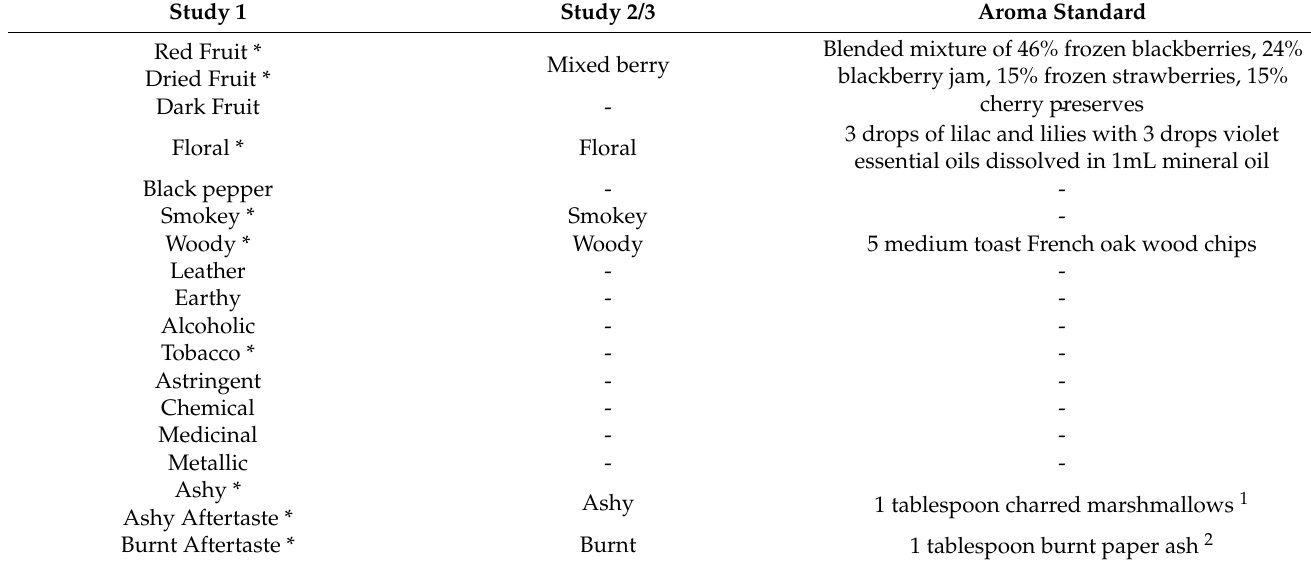
Table 2. Attributes evaluated during the CATA (Study 1) and TCATA (Study 2), along with standards used for training prior to FTPT (Study 3).